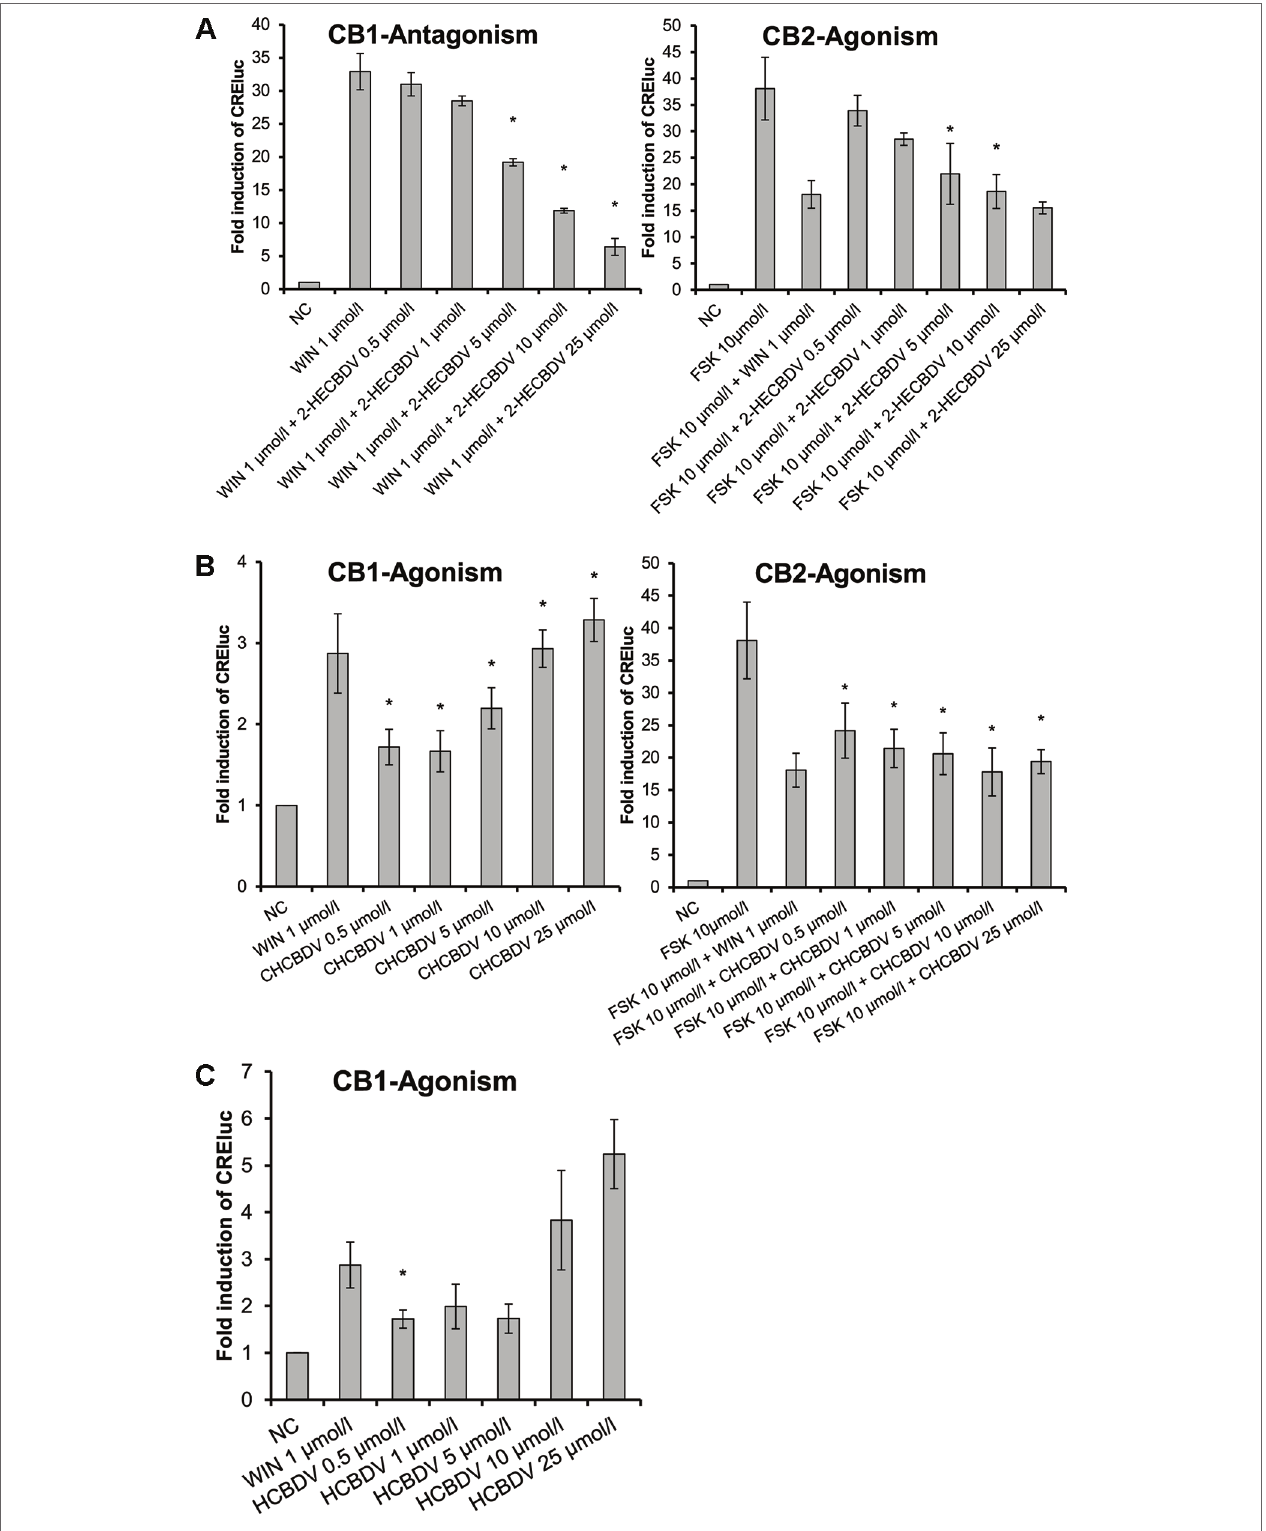
FigURE 5 | CB‑receptor‑mediated effect of CBDV‑derivatives. The following compounds were tested: (a) 2‑HECBDV ( 7 ), (B) CHCBDV ( 8 ), and (C) HCBDV ( 9 ). Given are fold induction of CRE‑luc; CB, cannabinoid; CBDV, cannabidivarin; CHCBDV, cyclohexyl cannabidivarinolate; HCBDV, n ‑hexyl cannabidivarinolate; NC, negative control; WIN, WIN 55212‑2; 2‑HECBDV, 2‑hydroxyethyl cannabidivarinolate; error bars represent SEM, n = 4 independent experiments, * p < 0.1.